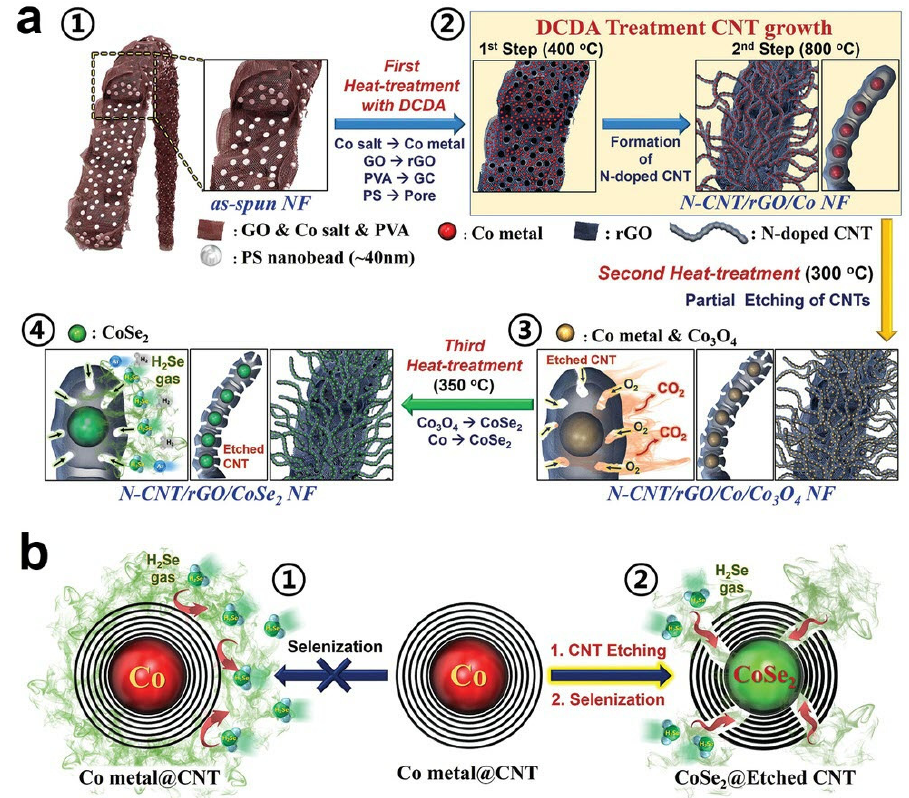
Figure 13. ( a ) Formation mechanism of the golden bristlegrass-like graphene matrixed nanofibers entangled with bamboo-like N-CNTs containing CoSe 2 nanocrystals at each node and ( b ) efficient conversion of Co to CoSe 2 by partial etching strategy of N-CNT wall. Reproduced with permission [90]. Copyright 2019, Wiley-VCH.